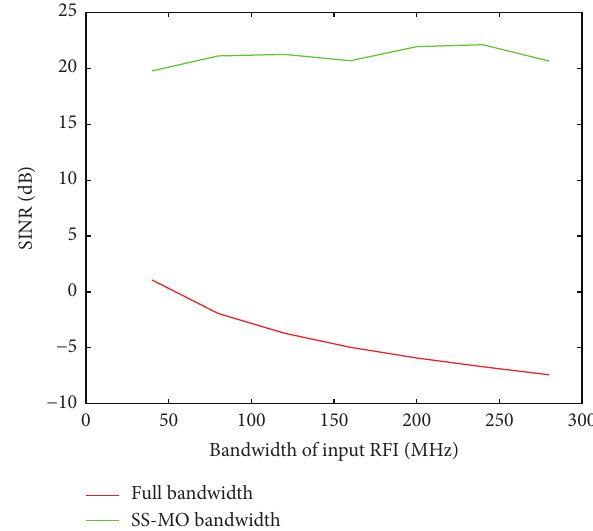
Figure 12: The SINR results of the wideband RFI